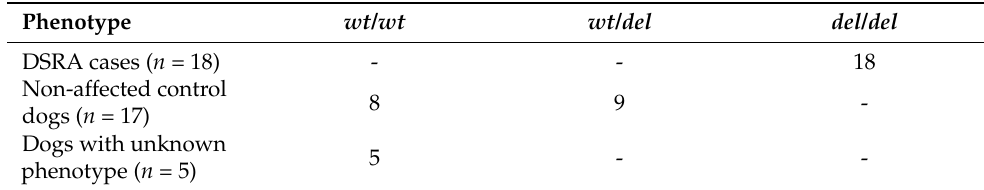
Figure 3. Details of the MIA3 :3822+3_3822+4del variant. ( A ) Sanger sequencing electropherograms of a control and a DSRA affected dog illustrate the 2 bp deletion at the beginning of intron 9 of the MIA3 gene; ( B ) Pedigree of a Cane Corso family shows the expected co-segregation of the genotypes at the deletion with the DSRA phenotype assuming monogenic autosomal recessive inheritance. Table 2. Association of the genotypes at the MIA3 :3822+3_3822+4del variant with DSRA in 40 Cane Corso dogs.